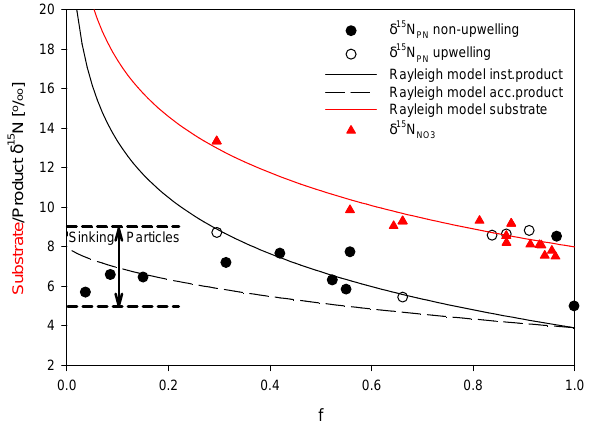
Fig. 6. Lines indicate results of the Rayleigh closed system model using the isotopic effect ε = 4.1‰ calculated for the samples of substrate (red triangles) and the δ 15 N PN (dots) this study. δ 15 N NO 3 are measured in the Arabian Sea surface mixed layer are indicated. Values are given in Table 1; f was calculated according to Eq. (3). The range of δ 15 N of sediment trap samples is indicated by arrows (data in Supplement